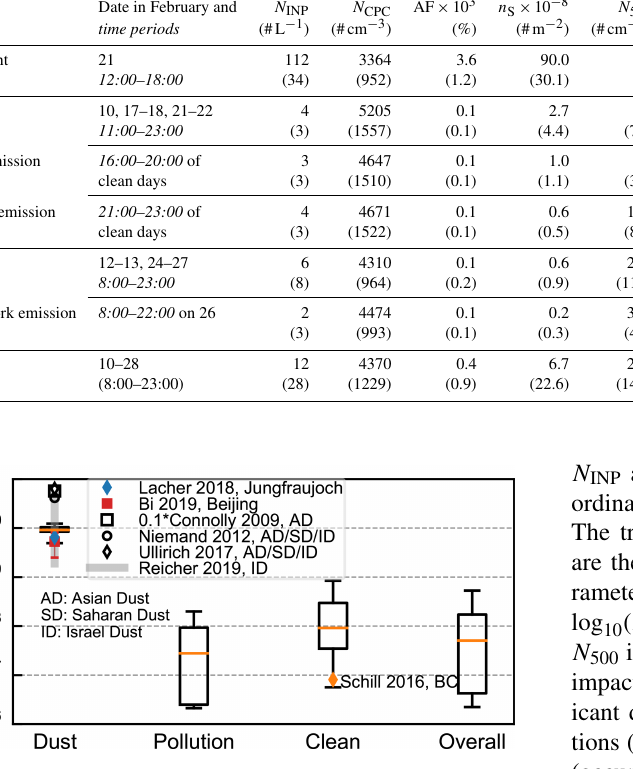
Figure 5. Ice-active surface site density ( n S ) for different scenar- ios. The median (horizontal orange lines), 25th and 75th percentiles (lower and upper boxes), and 10th and 90th percentiles (lower and upper whiskers) are